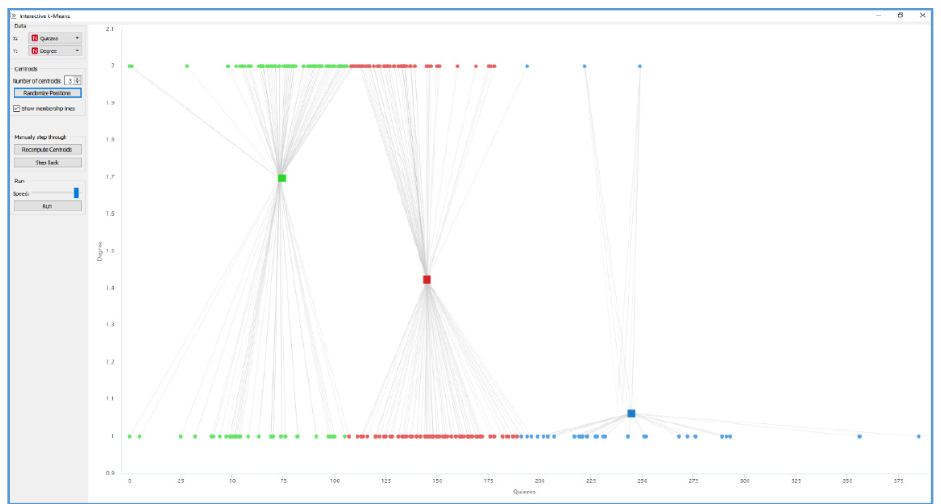
Figure 11. Visualization of clusters showing degree student behaviour (1 = nursing degree, 2 = occupational therapy degree) for the variable quizzes.